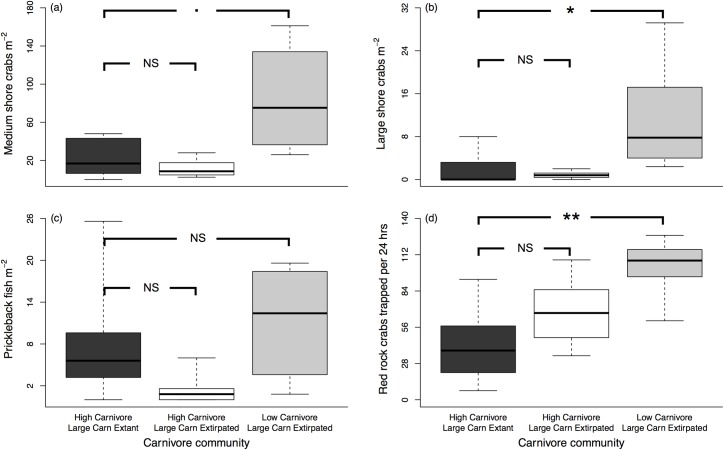
Comparison of intertidal prey abundances where large carnivores are extant (Clayoquot) or extirpated (Gulf Islands).Shown are abundances of (a) medium shore crabs, (b) large shore crabs, and (c) prickleback fish per m2; and (d) red rock crabs trapped per 24 hrs from locations where carnivore abundance is high and large carnivores are extant (Clayoquot sound [n = 10 sites], dark boxes), where carnivore abundance is high and large carnivores are extirpated (raccoon-present Gulf Islands [n = 6], white boxes), and where carnivore abundance is low and large carnivores are extirpated (raccoon-absent Gulf Islands [n = 6], grey boxes). Data are presented as standard boxplots; the bold horizontal black lines indicate median values, the box edges represent the 25 and 75% quartiles, and the whiskers signify the range. The endpoints of brackets across the top indicate groups of data compared in statistical tests. N.S., non-significant; 0.06 > P > 0.05; * P < 0.01; ** P < 0.001.